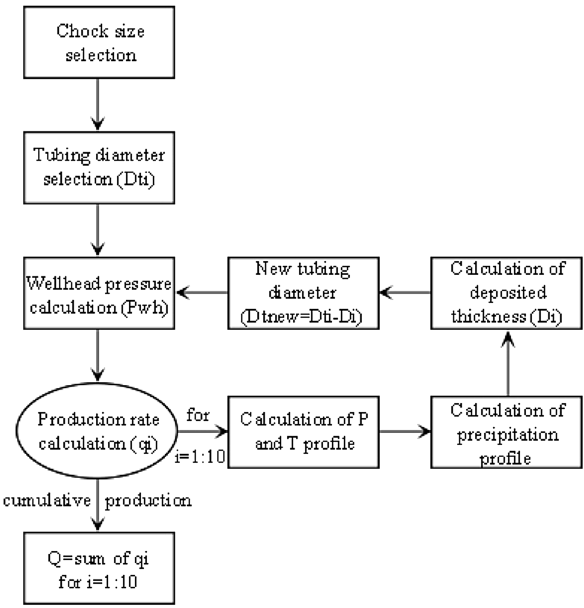
Fig. 24 Thickness of deposited asphaltene under optimum conditions of production in depth of 12,000